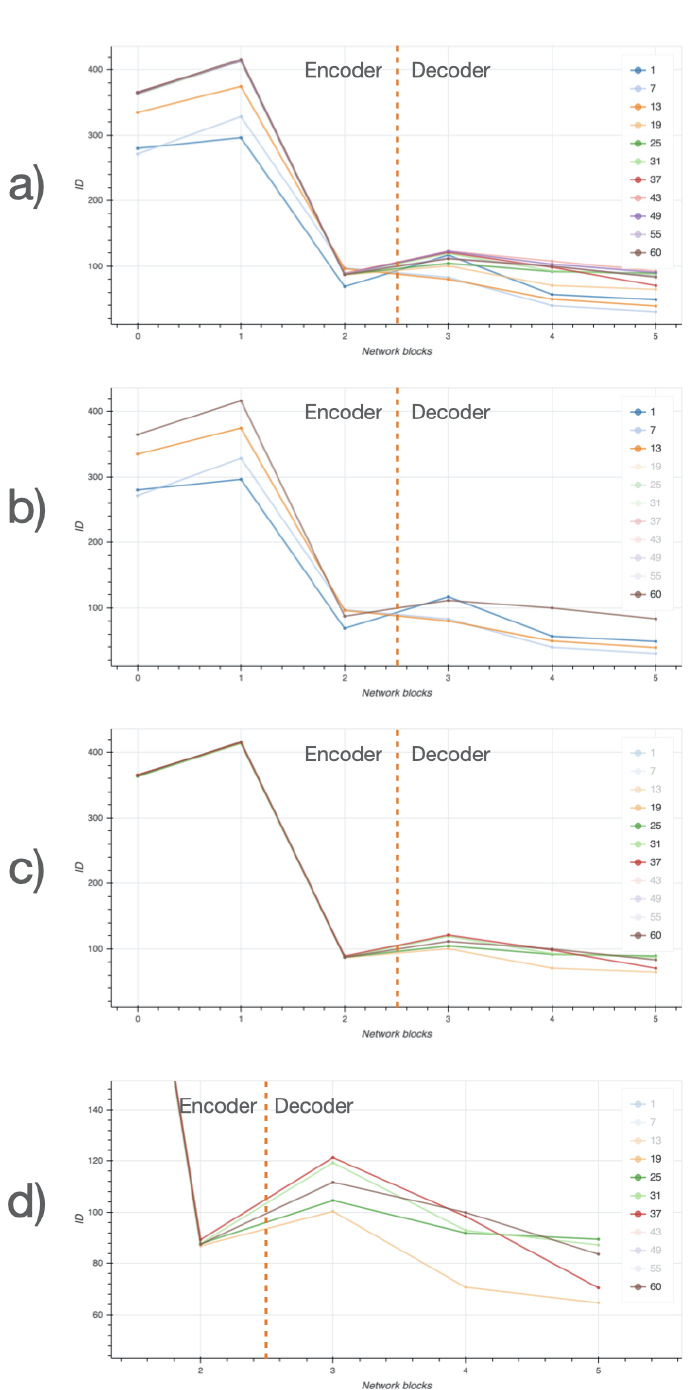
Figure 18. Intrinsic dimensionality (ID) along different layers of the EUNet network, at different training stages. ( a ) ID across layers for all training checkpoints, ( b ) ID across layers for first three training checkpoints, ( c ) ID across layers for intermediate training checkpoints, ( d ) ID across layers for intermediate checkpoints, zoomed on the decoder. Legend includes all different epochs; ID curves corresponding to transparent elements of the legend are not